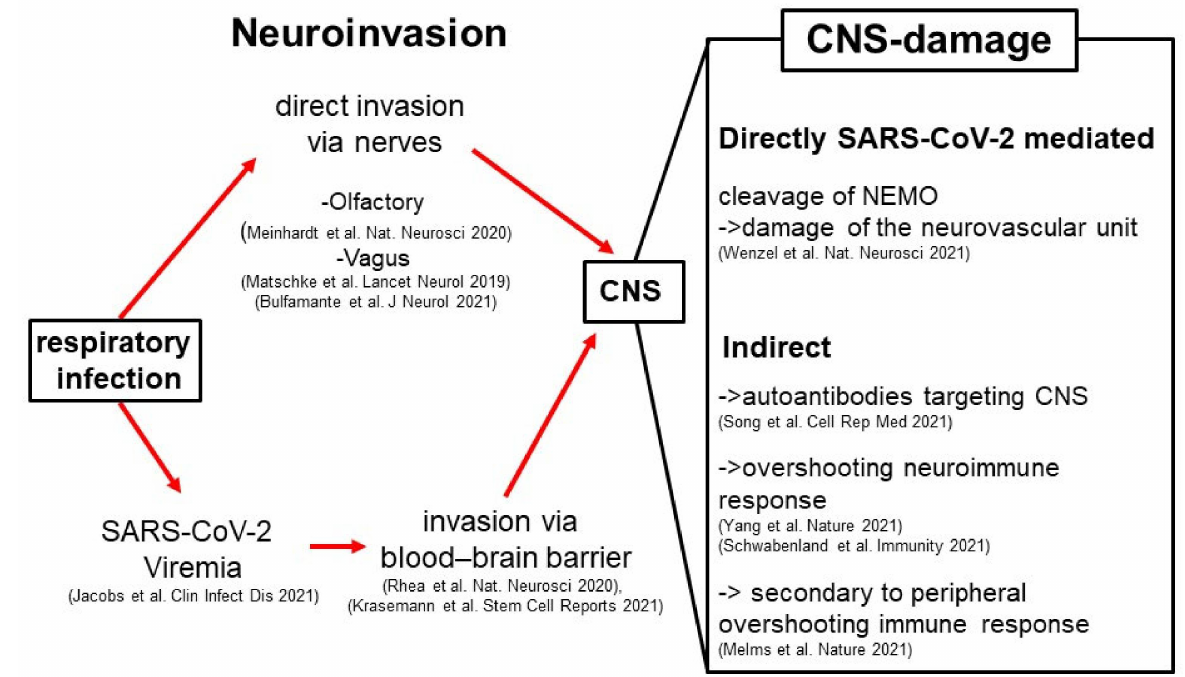
Figure 1. Possible routes of SARS-CoV-2 neuroinvasion and potential modes of action concerning CNS damage, as seen in